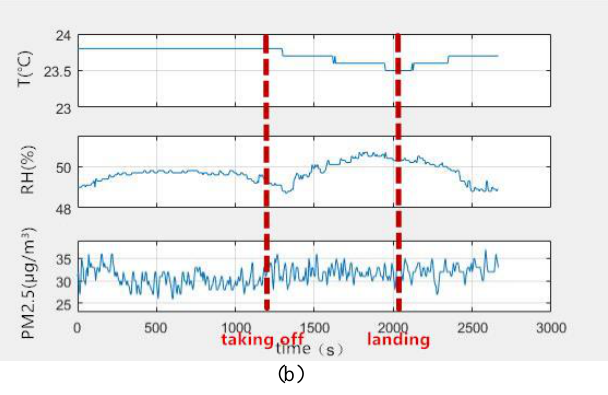
Figure 4 Flow field when the rotor is tilted outward/horizontal/inward